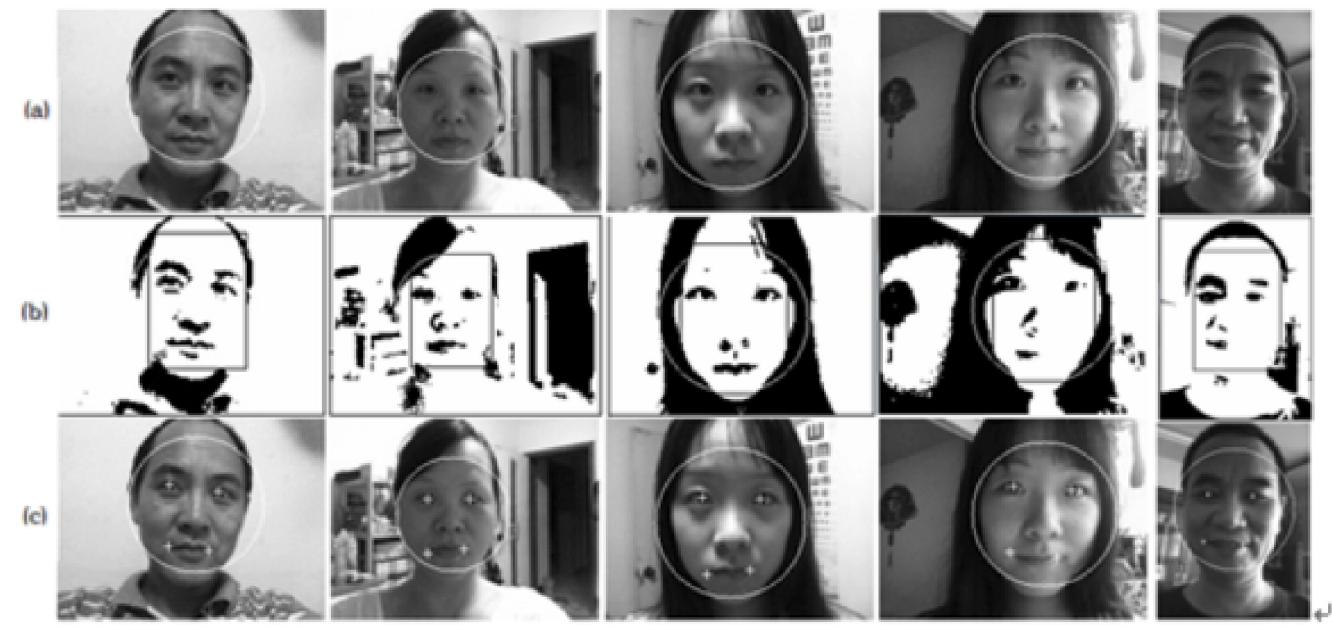
Fig 4. Feature detection